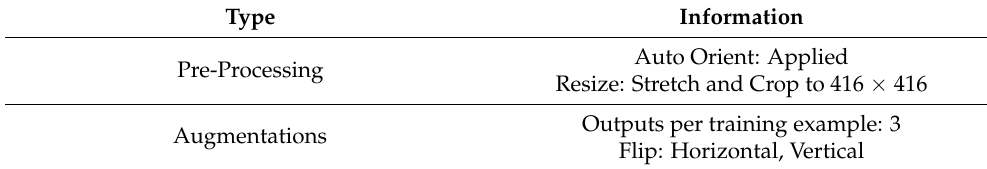
Table 3. Data pre-processing